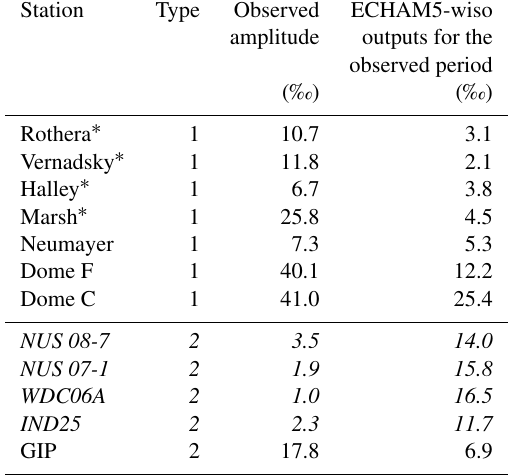
Table 8. The d mean seasonal amplitude (in ‰) calculated for pre- cipitation at daily or monthly scale (identified with an asterisk) and sub-annual ice core data, as well as simulated by ECHAM5-wiso for the same time period as each record. The data type is identified as 1 for precipitation samples and 2 for ice core records. Ampli- tude values that are overestimated by ECHAM5-wiso are written in